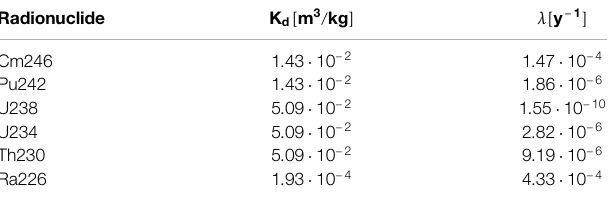
TABLE 2 | Radionuclide-speci fi c parameters for the Decay Chain case . Radionuclide